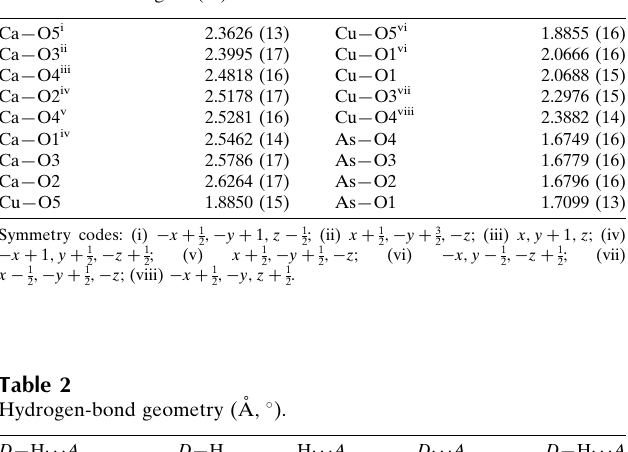
Selected bond lengths (A˚ ).